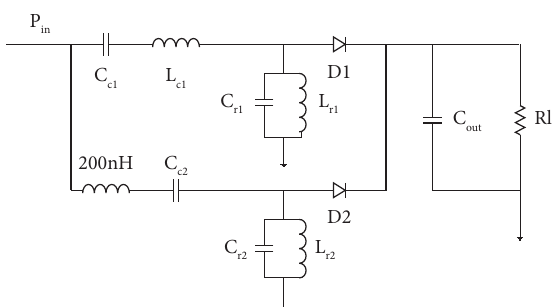
Figure 21: Rectifer adopting the design of Figure 20.